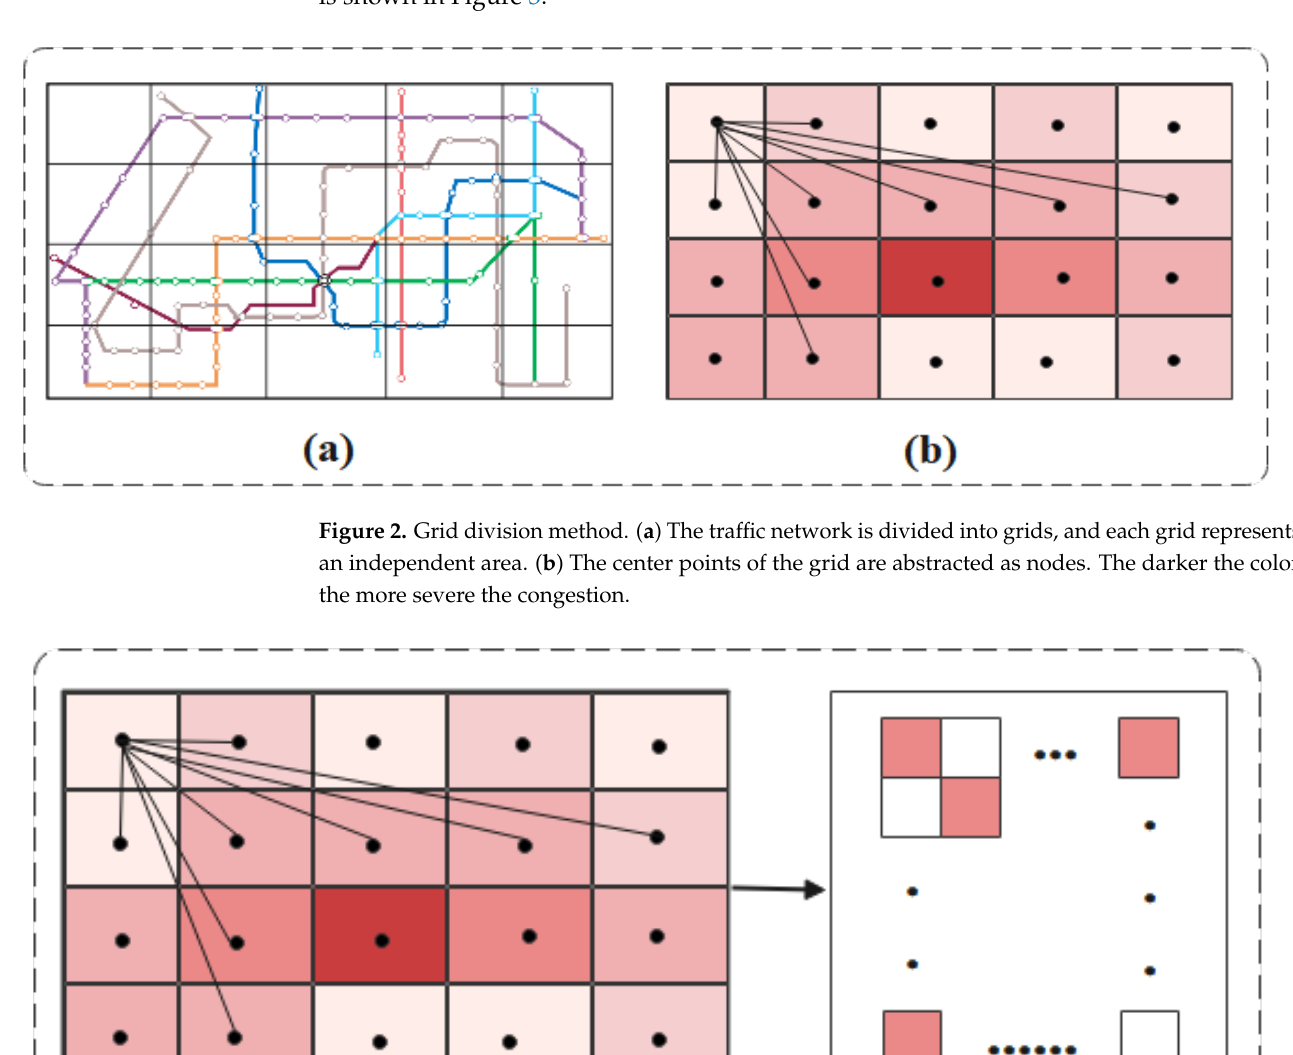
is shown in Figure 3. Figure 2. Grid division method. ( a ) The traffic network is divided into grids, and each grid repre- sents an independent area. ( b ) The center points of the grid are abstracted as nodes. The darker the color, the more severe the congestion.